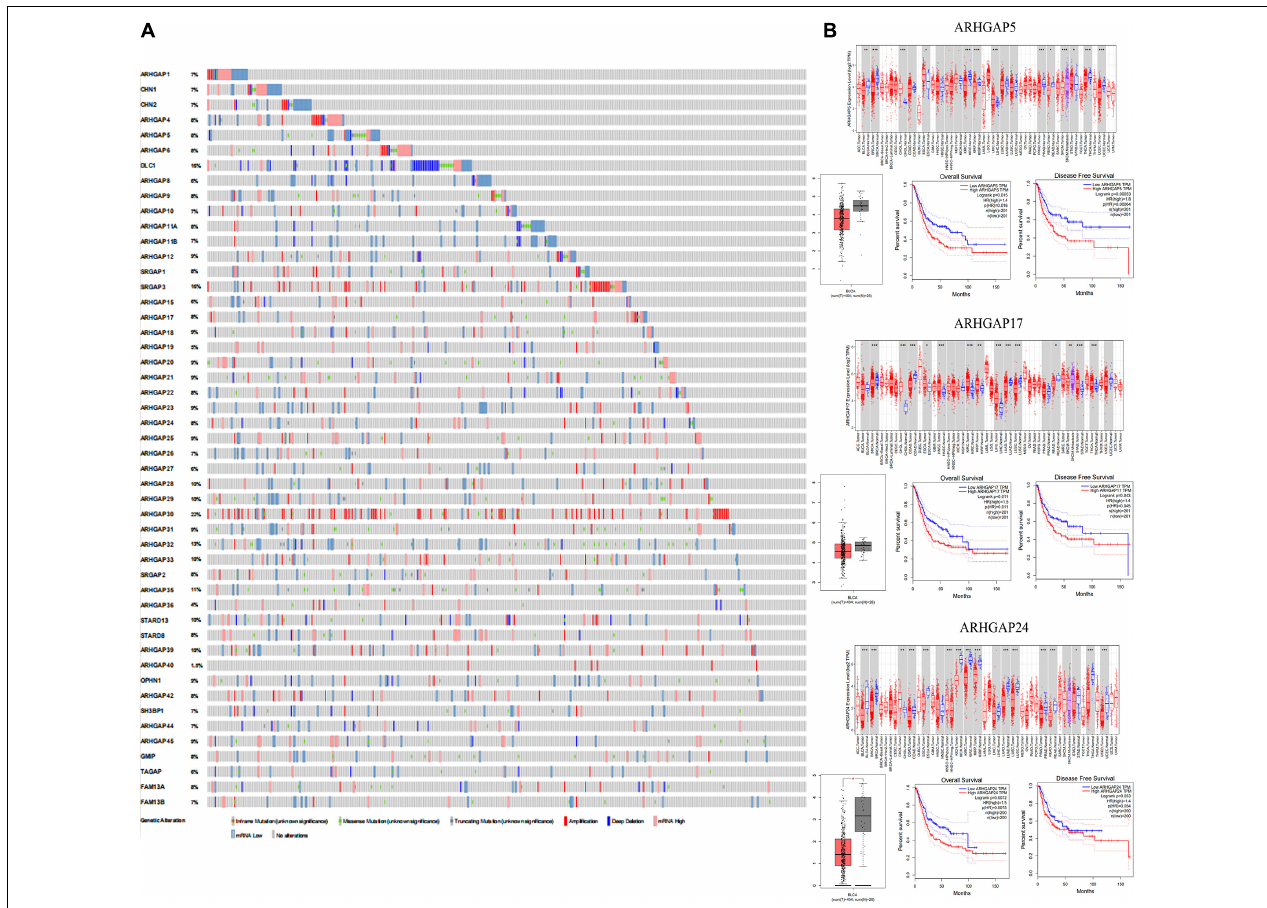
FIGURE 1 | Identification of expression profile and prognosis related to the Rho-GTPase-activating proteins (ARHGAP) family gene in bladder cancer (BCa). (A) ARHGAP mutation level in BCa according to the analysis of cBioPortal. (B) Expression level of ARHGAP5, ARHGAP17, and ARHGAP24 in several tumor and normal tissues and Expression, OS and DFS of ARHGAP5 in